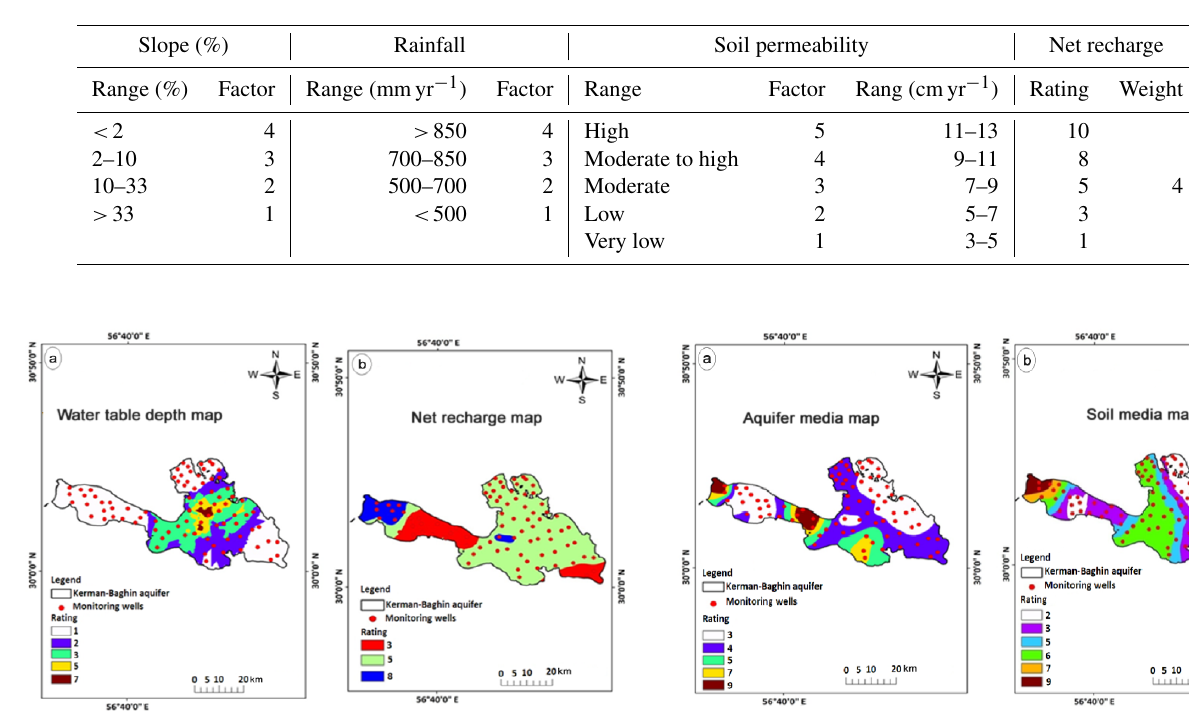
Figure 3. The Kerman–Baghin aquifer rated maps of (a) aquifer media and (b) soil media.